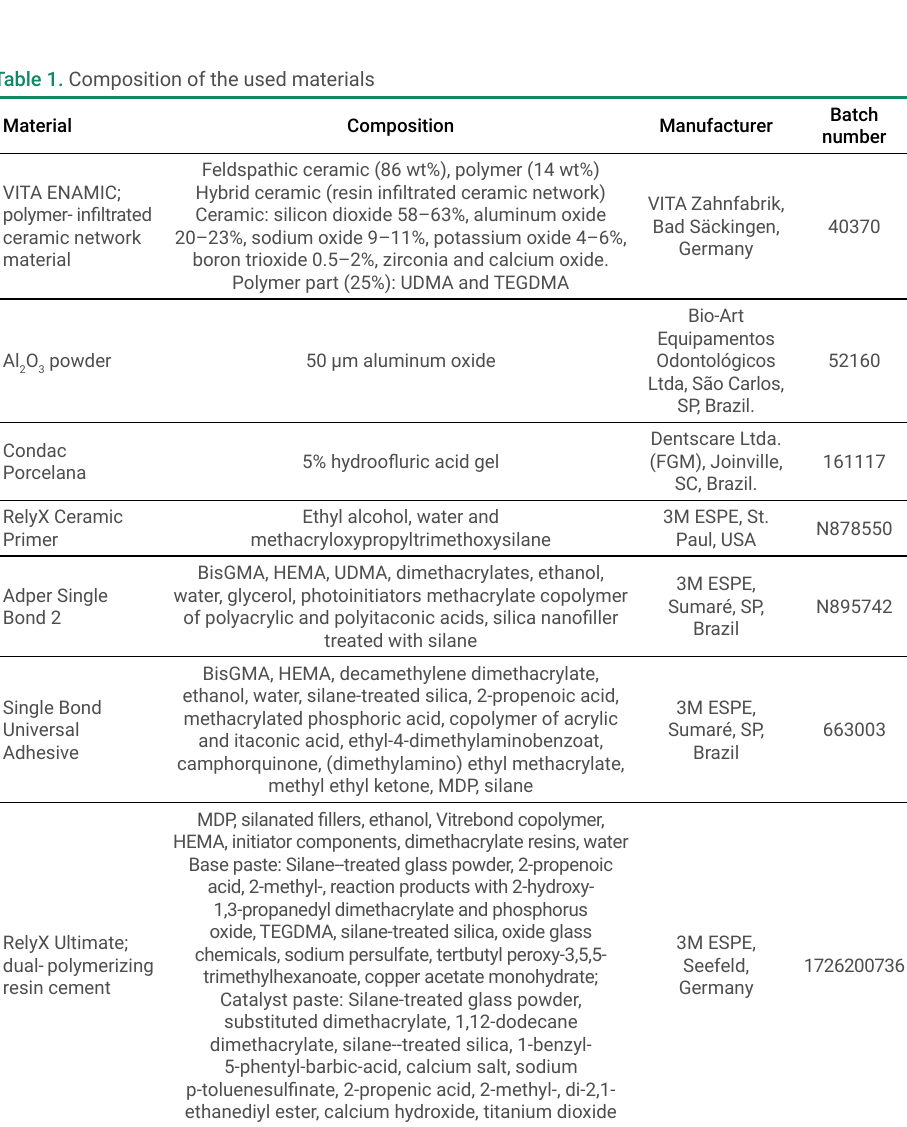
Table 1. Composition of the used